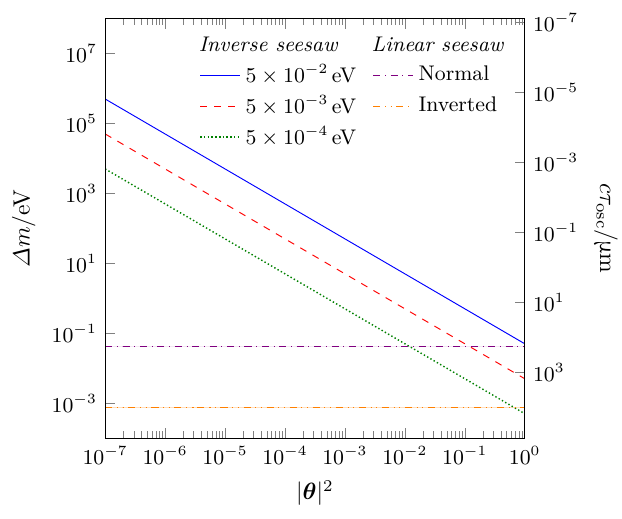
Figure 7 . Heavy neutrino mass splitting as a function of the active-sterile mixing parameter for the five BMs of the minimal linear and inverse seesaw given in table 1